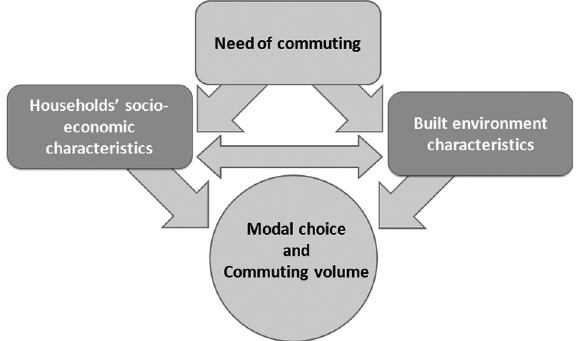
fig. 3. Conceptual model explaining the need of commuting. Source: own